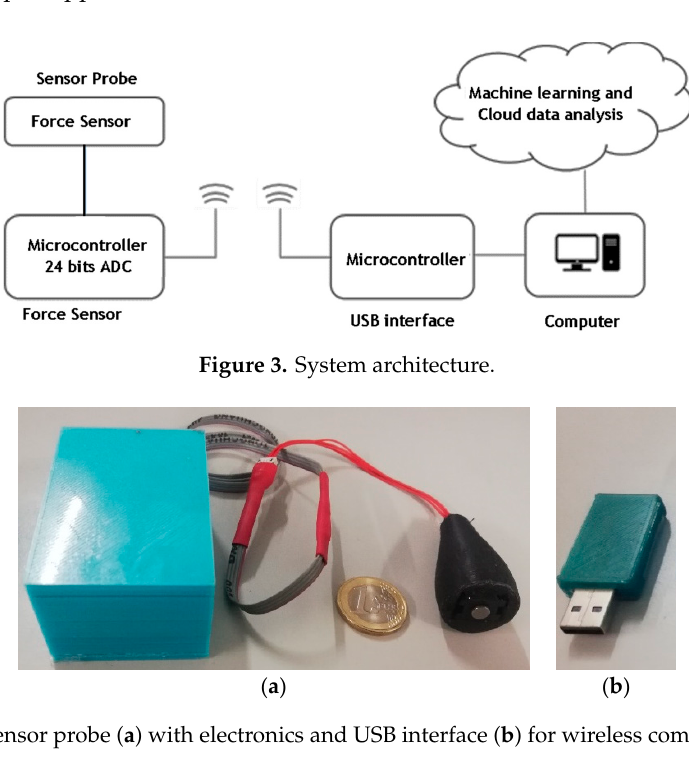
Figure 4. Sensor probe ( a ) with electronics and USB interface ( b ) for wireless communication.